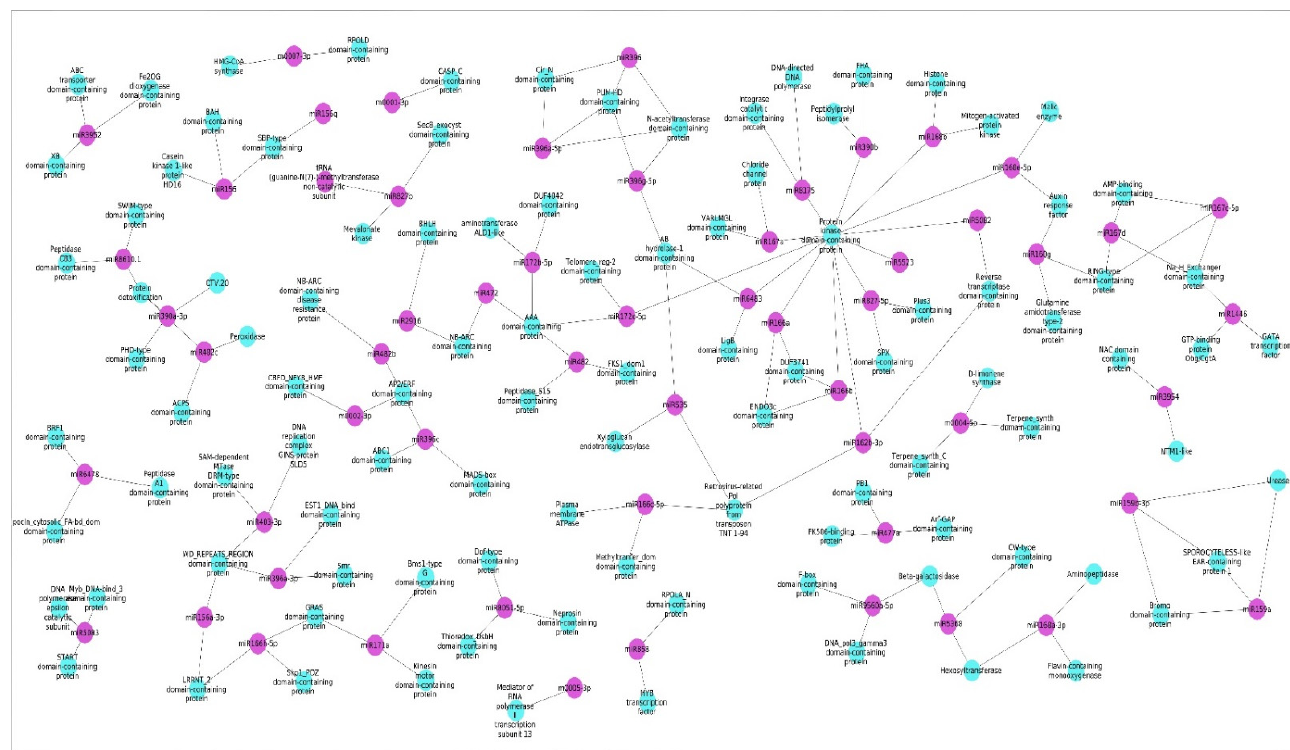
Figure 5. MFE-based network interaction of M. koenigii miRNAs and their corresponding potential targets. Coregulation of multiple targets was observed for several of the identified miRNAs (weaker energy interactions were marked as dotted lines).